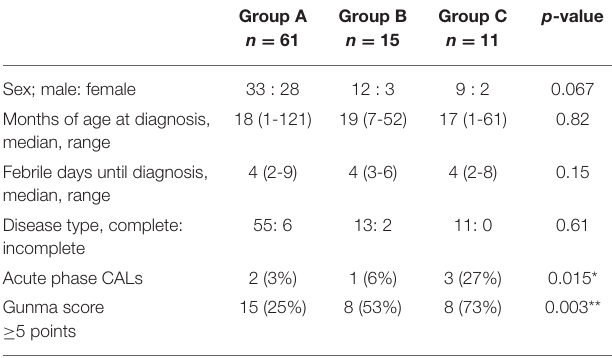
analyses were performed using JMP R (cid:13) 13 (SAS Institute Inc., Cary, NC, USA).